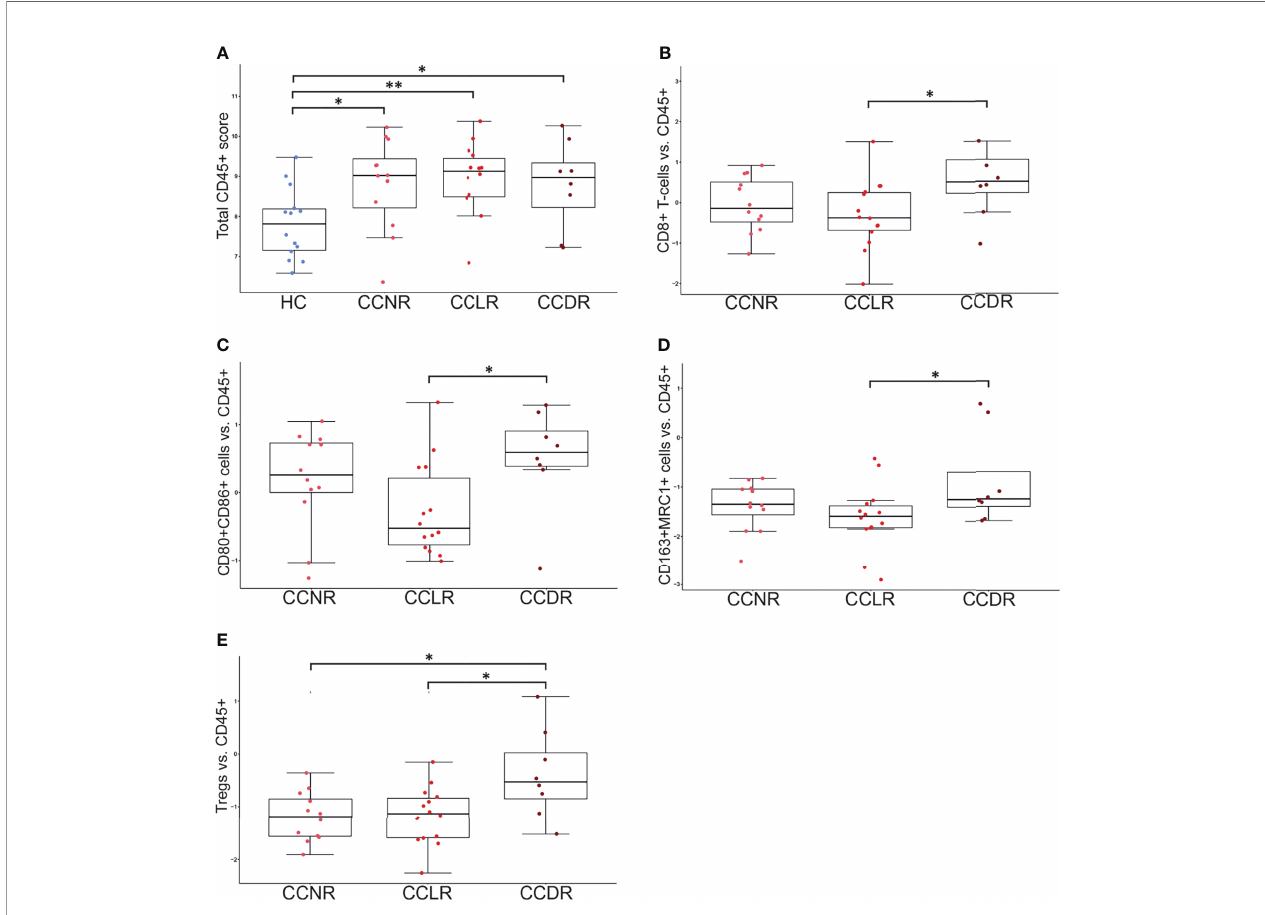
FIGURE 4 | Immune cell populations in cervical cancer tissue. Each dot represents one sample. Y-axis indicates the immune cell score (ratio of given cell type relative to CD45+ immune cells). *P < 0.05, **P < 0.01. (A) Total CD45+ lymphocyte score. HC show signi fi cantly lower CD45+ cells compared to any cervical cancer group. (B) CD8+ T cells vs. CD45: signi fi cant differences between HC vs. each cervical cancer group and CCLR vs. CCDR. (C) CD80+CD86+ Macrophages vs. CD45: signi fi cant differences between HC vs. each cervical cancer group and CCLR vs. CCDR (D) CD163+MRC1+ Macrophages vs. CD45: signi fi cant differences between HC vs. each cervical cancer group and CCLR vs. CCDR. (E) Tregs vs. CD45: signi fi cant differences between HC vs. CCLR, HC vs. CCNR, CCNR vs. CCDR, and CCLR vs. CCDR. Tregs, Regulatory T cells; HC, Healthy controls; CCLR, Cervical cancer local recurrence; CCDR, Cervical cancer distant recurrence; CCNR, Cervical cancer no